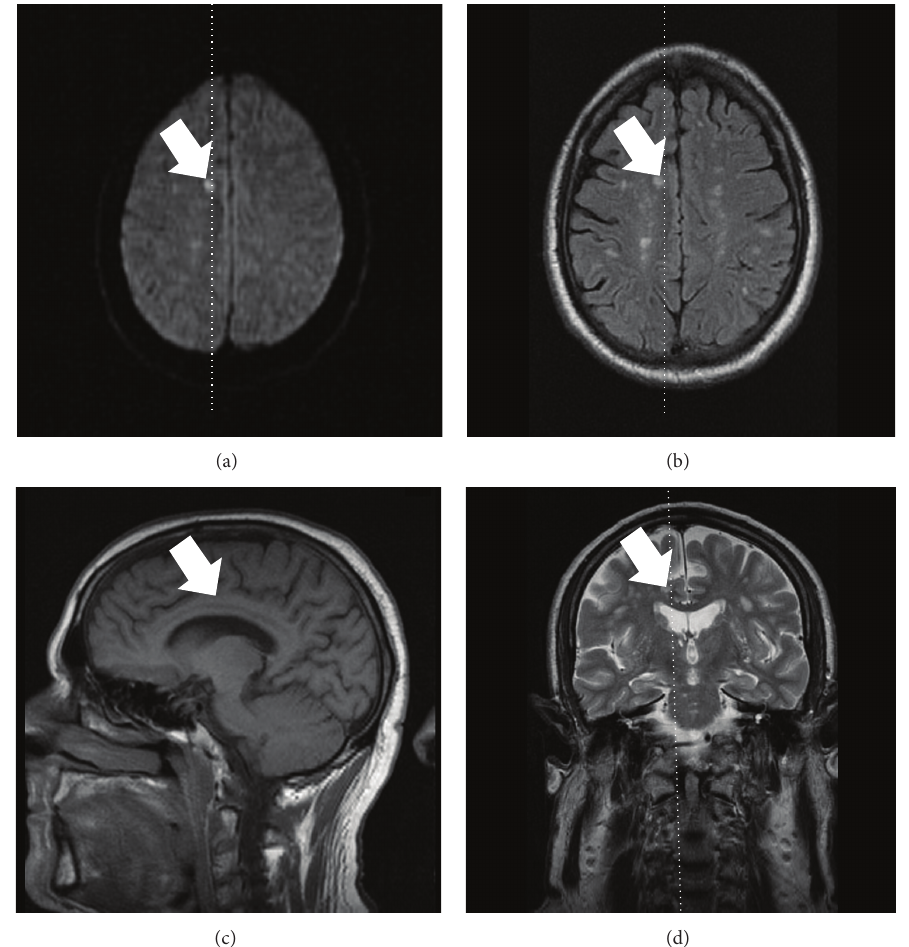
Figure 1: Right small acute cingulate gyrus infarct was found by magnetic resonance imaging on diffusion-weighted images study (a), T2- weighted image ((b) and (d)), and T1-weighted image (c) on 72 hours after onset of transient global